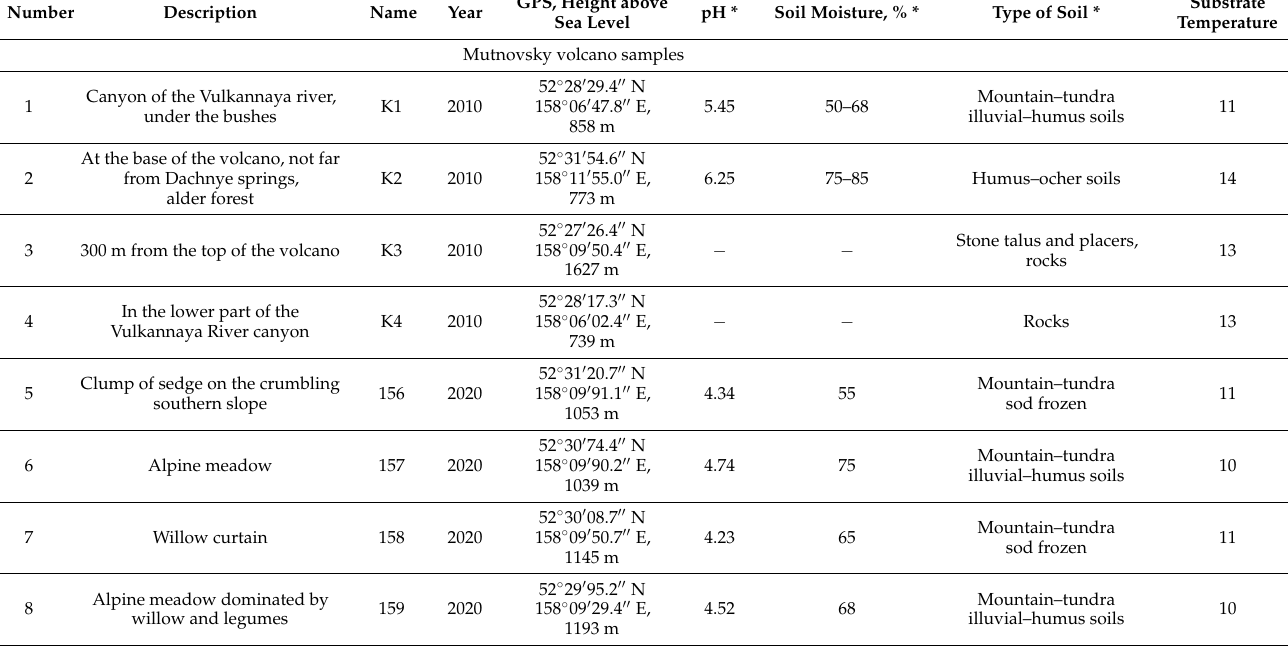
Table 1. Sampling